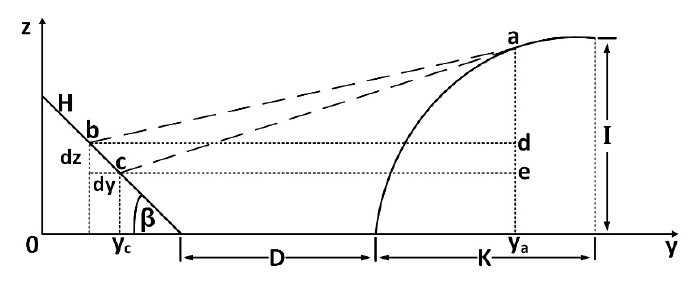
Figure 11. Collector facing a convex building roof.